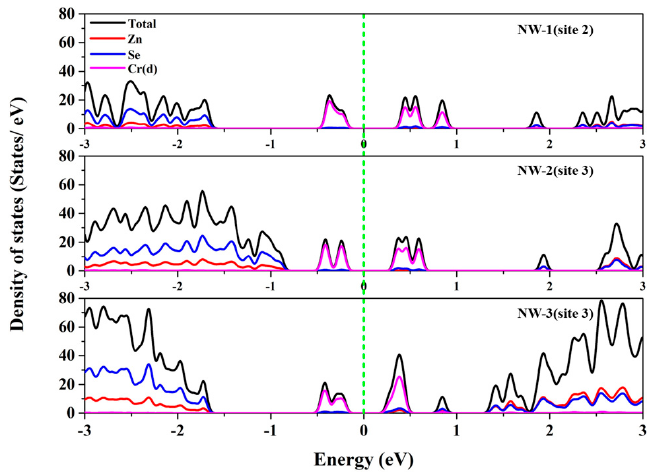
Figure 3. The DOS of Cr 2+ :ZnSe NWs in different sizes.